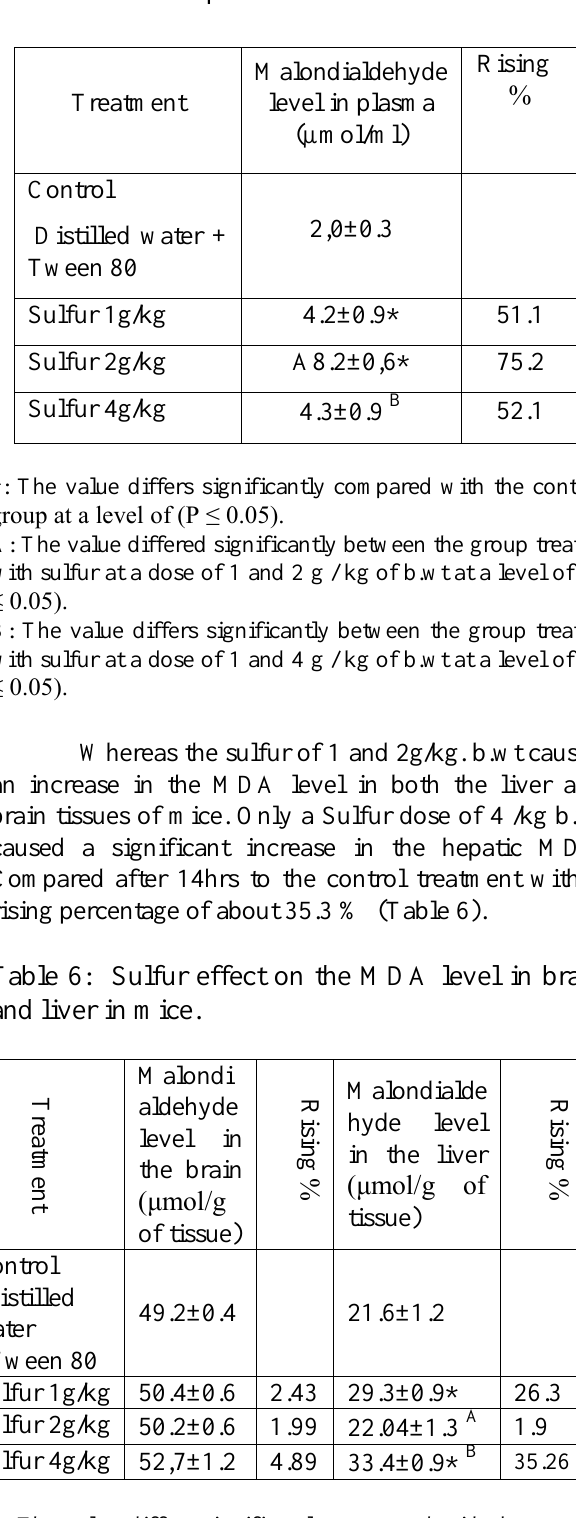
Table 5: Sulfur effects on the Malondialdehyde level in the blood plasma of the mice.